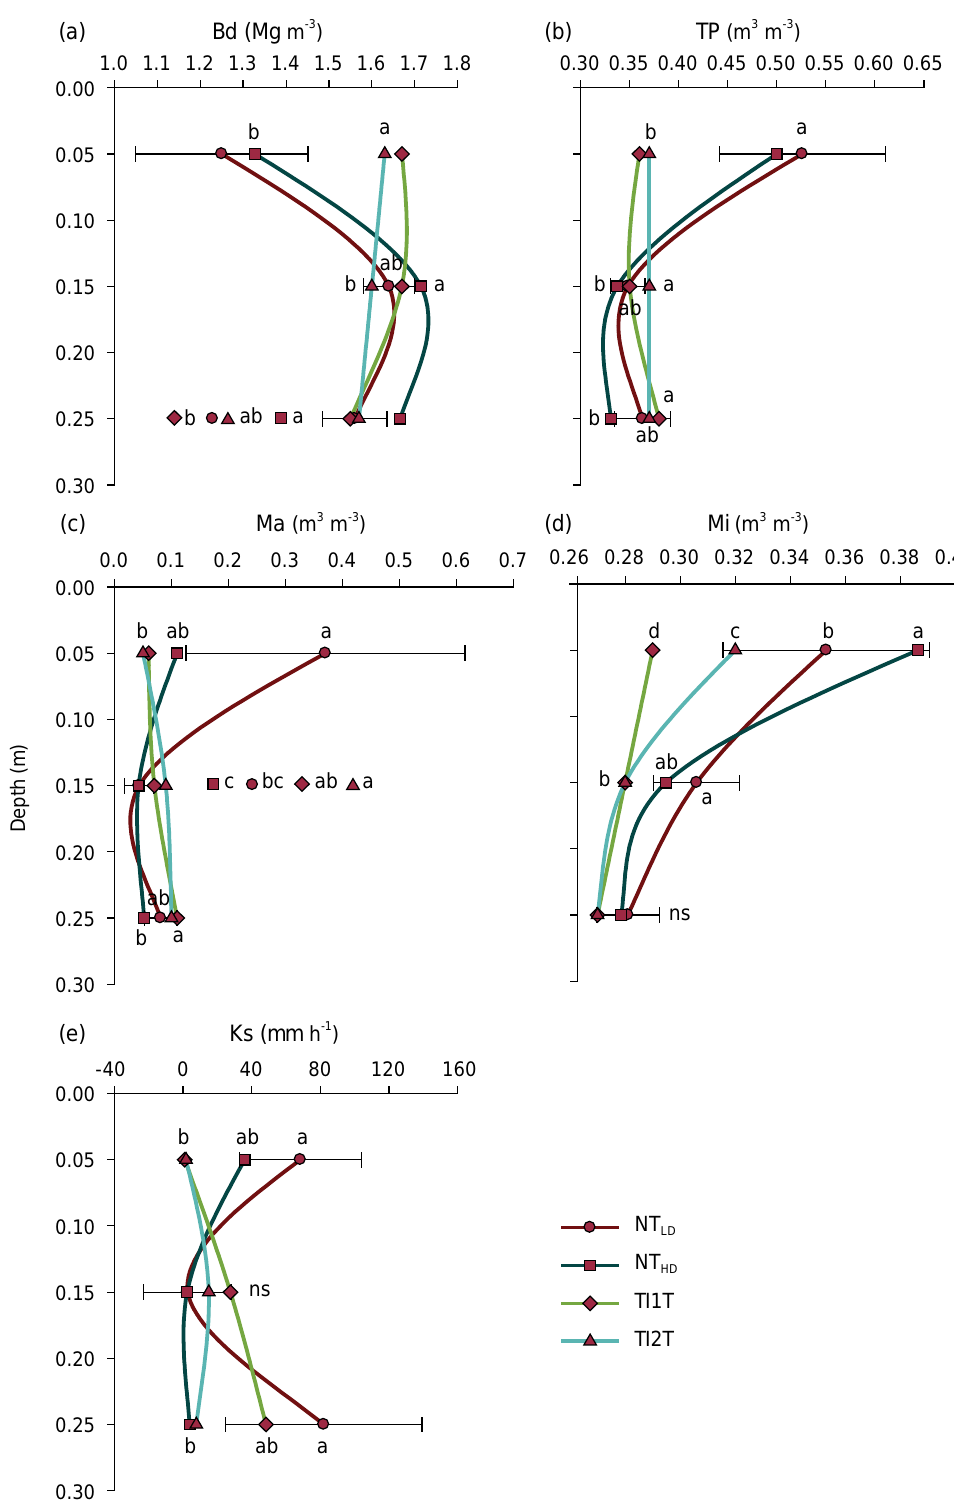
Figure 7. Soil bulk density (Bd) (a), total porosity (TP) (b), macroporosity (Ma) (c), microporosity (Mi) (d), and saturated hydraulic conductivity (Ks) (e) in treatments with no traffic (NT LD and NT HD ) and after 1 and 2 pivoting maneuvers (TI1T and TI2T) of M113 BR. Averages followed by the same letter do not differ from each other by Tukey test (5 %). ns: not significant by Tukey test (5 %). The horizontal error bars represent the standard deviation of all